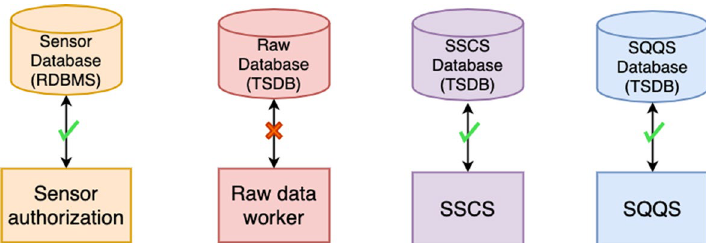
Fig. 16 Proposed system when database